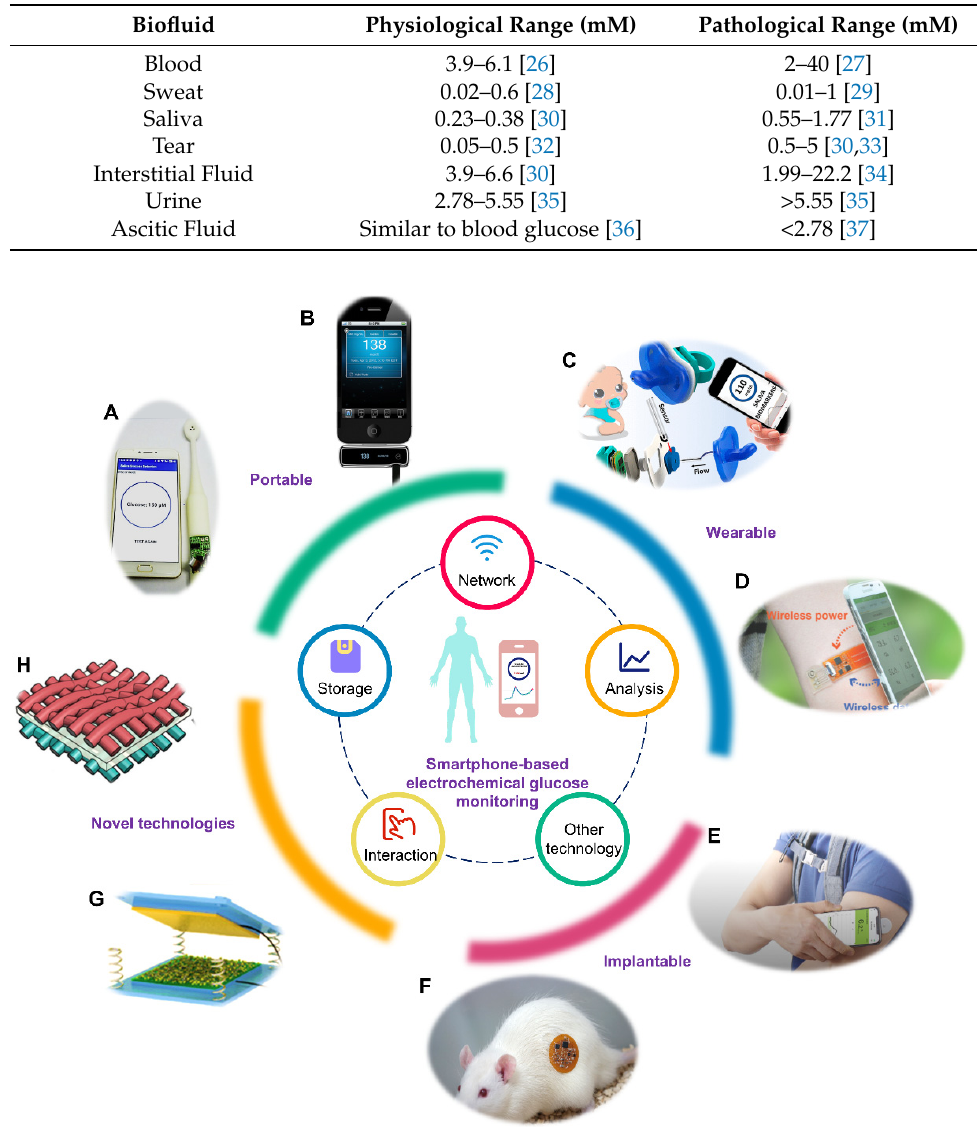
Figure 1. Smartphone-based electrochemical glucose monitoring system. The inner circle represents the technologies integrated in the smartphone. The outer circle represents the realization formats of smartphone-based electrochemical glucose monitoring and novel technologies utilized in this field.